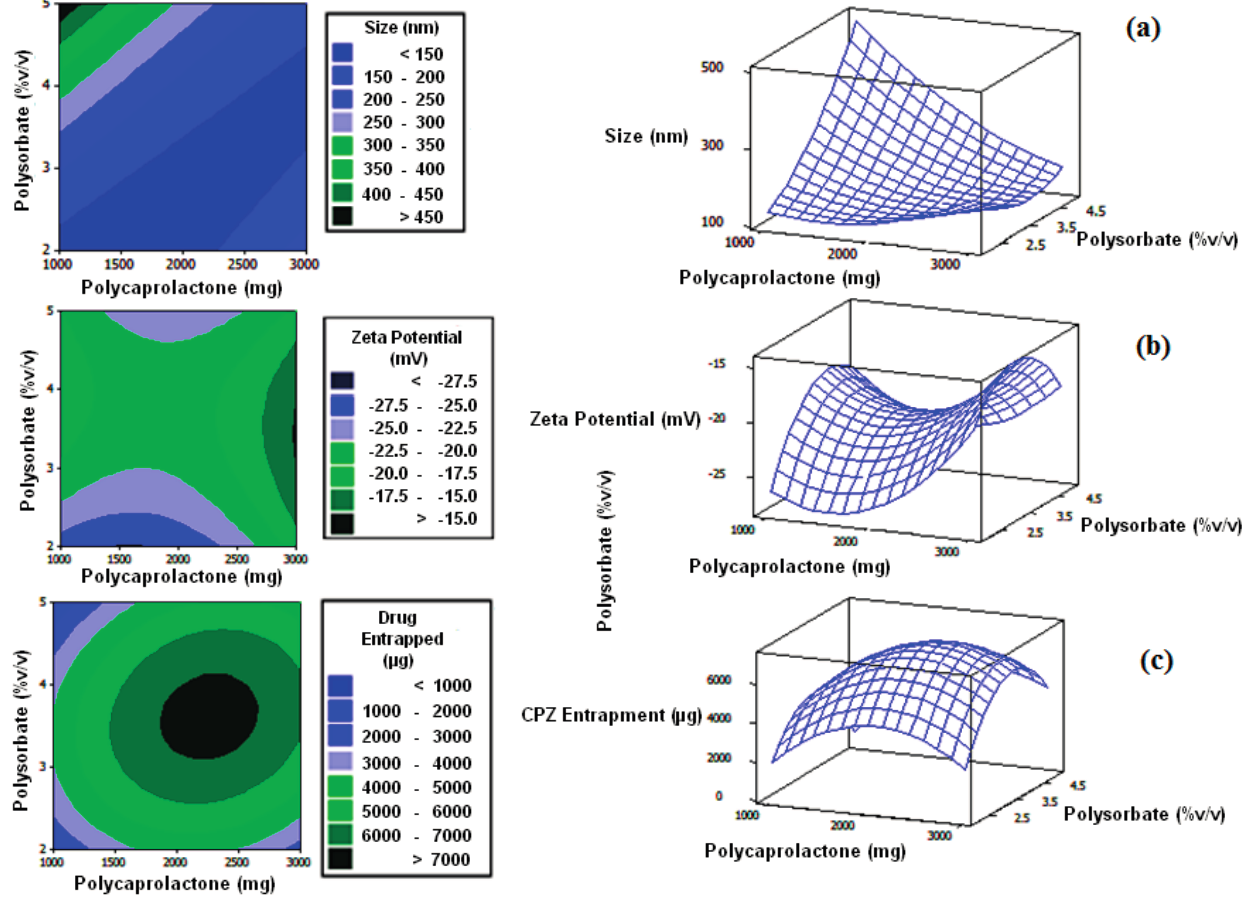
Figure 11. Response surface and contour plots depicting the effects of PCL and Polysorbate 80 on ( a ) size, ( b ) zeta potential and ( c ) CPZ